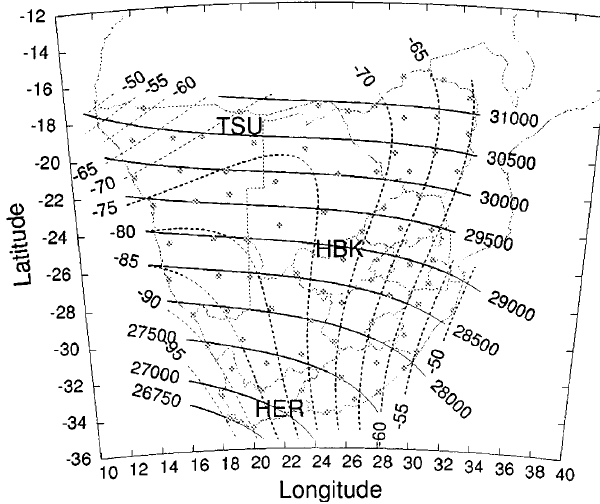
Fig. 1. Map of southern Africa showing the positions of the three continuous recording stations, HER , HBK , and TSU , and the field stations used for deriving the HMO’s geomagnetic field models. Also shown are the iso-contours of the geomagnetic field model for the total field F for epoch 1995; solid contours give the field intensities, while the dashed contours indicate the secular variation Table 1. Names, codes, and position coordinates of the observing stations whose data were used in the geomagnetic daily variation